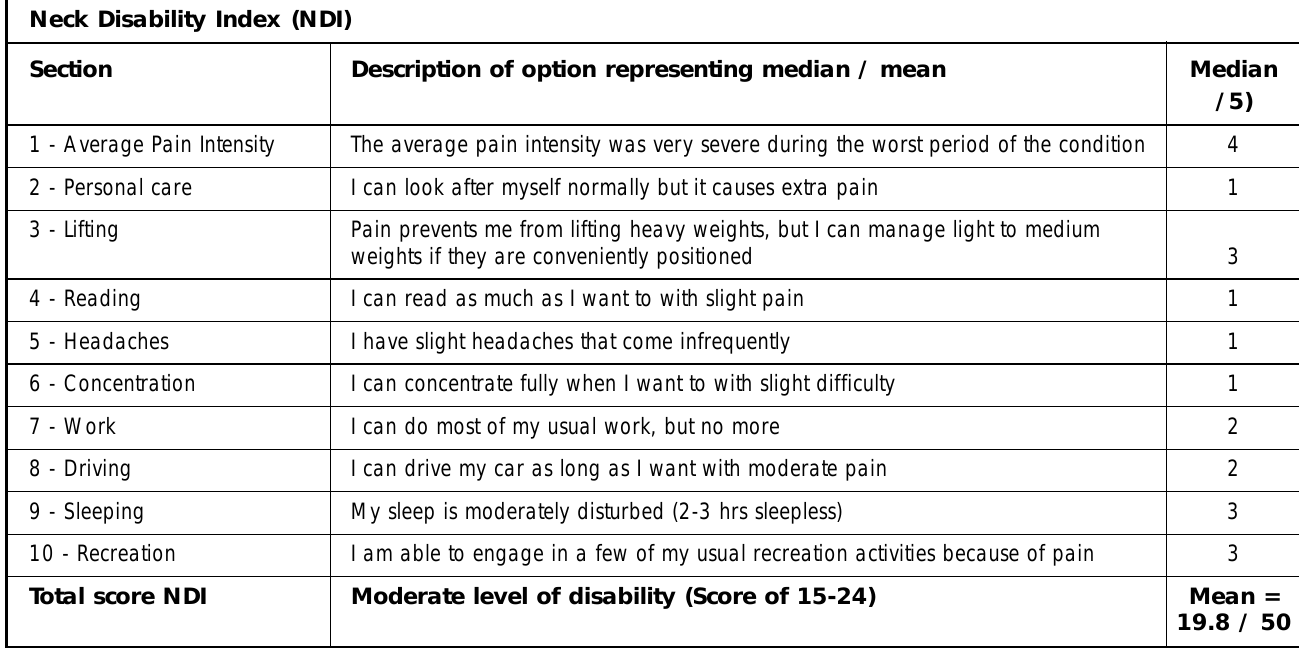
Table 2: Descriptions of the option representing the calculated median for each section of the NDI by the 21 subjects and the mean total score.